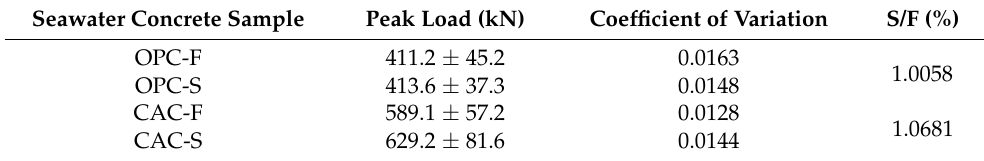
Table 3. Peak loads of four sets of seawater